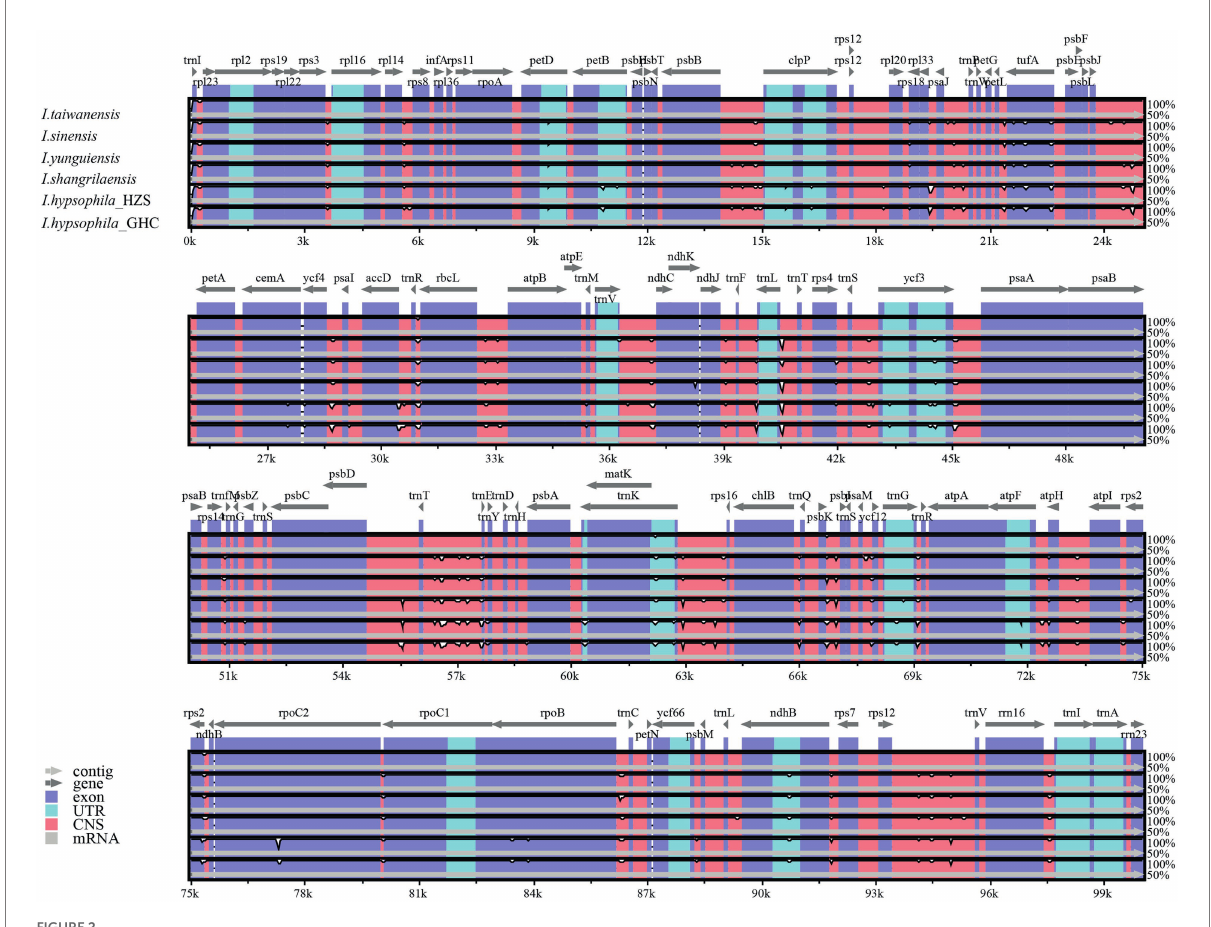
FIGURE 2 Comparison of the borders of LSC, SSC, and IR regions among six Isoetes chloroplast